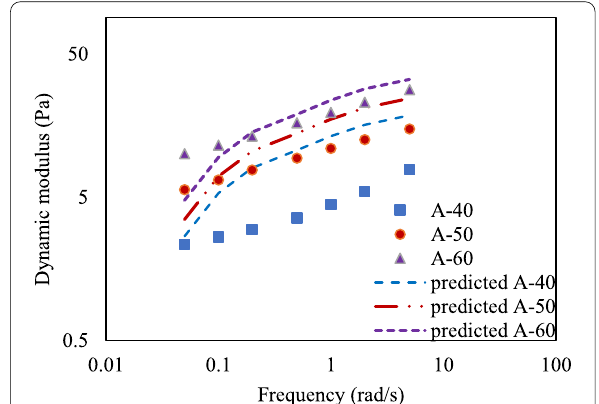
Fig. 14 Measured and predicted values of dynamic modulus by palierne